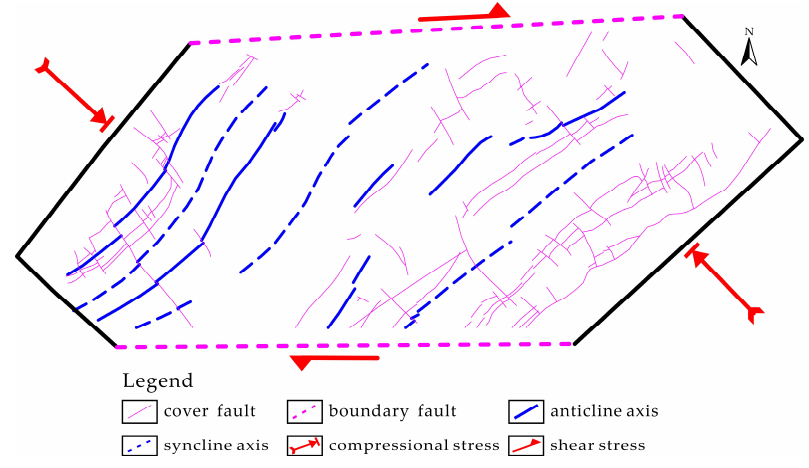
Minerals 2018 , 8 , x FOR PEER REVIEW